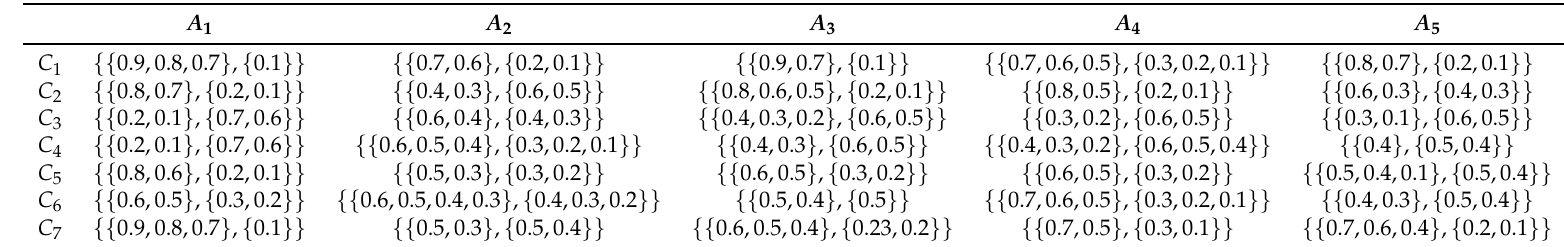
Table 6. Dual hesitant fuzzy decision